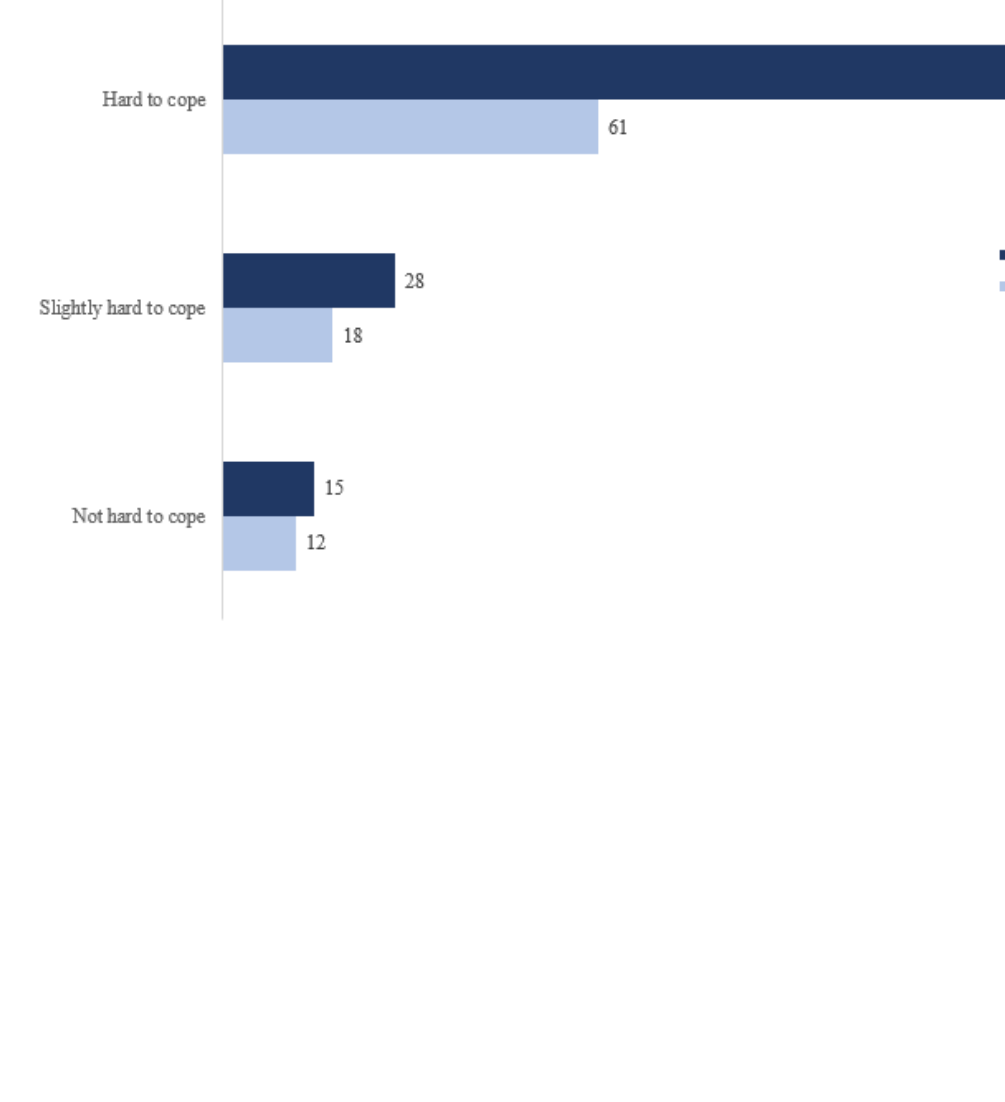
Figure 3. Coping experience–based feedback response